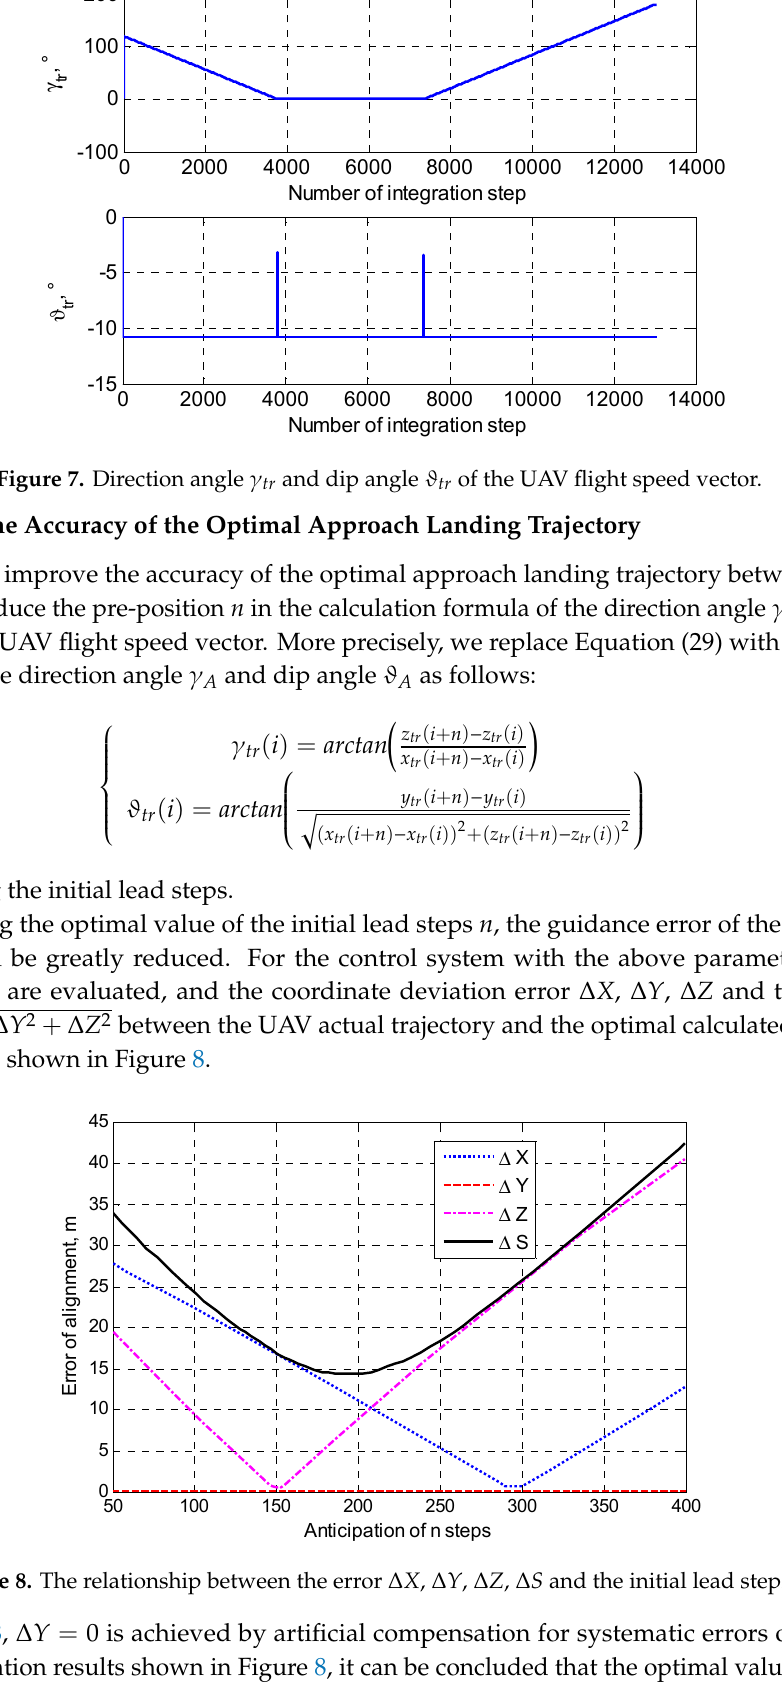
Figure 8. The relationship between the error ∆𝑋 , ∆𝑌 , ∆𝑍 , ∆𝑆 and the initial lead steps n .